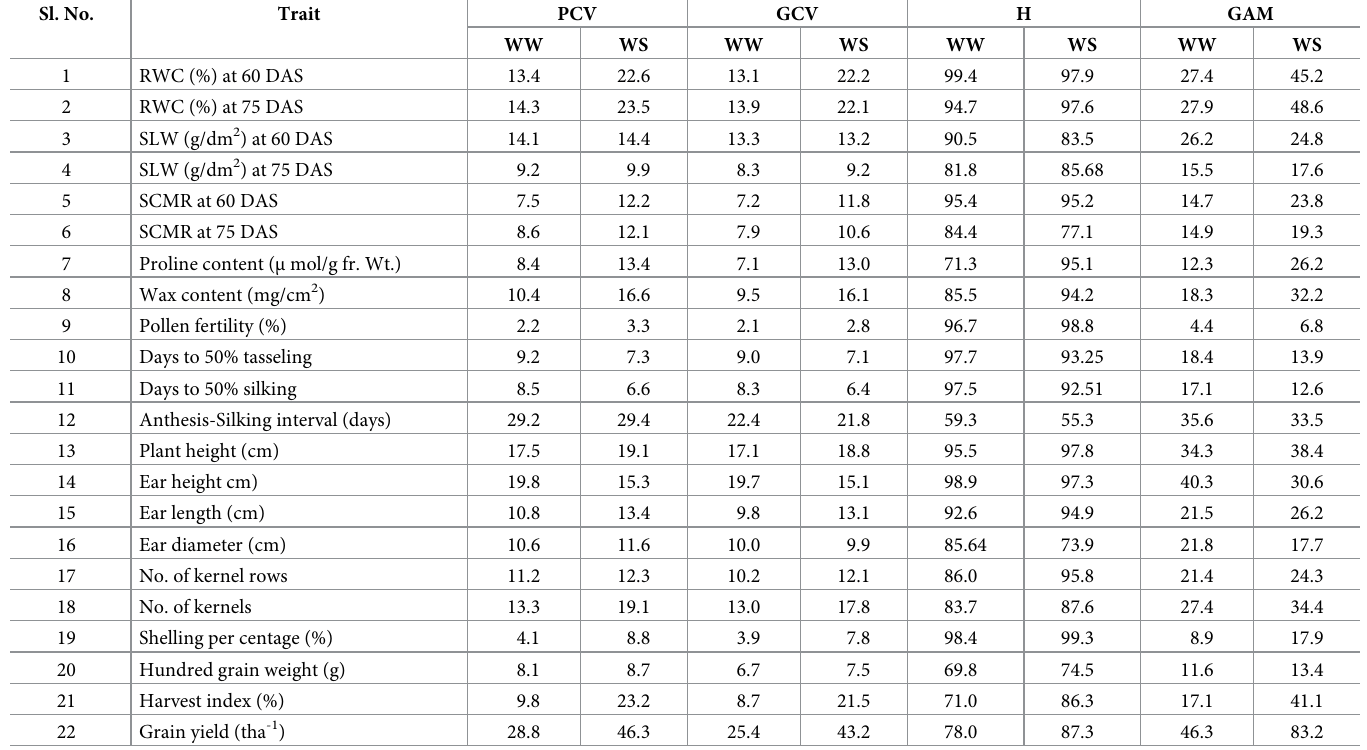
Table 4. Components of genetic variation for different traits under well watered and water stress condition of corn inbreds. Sl.